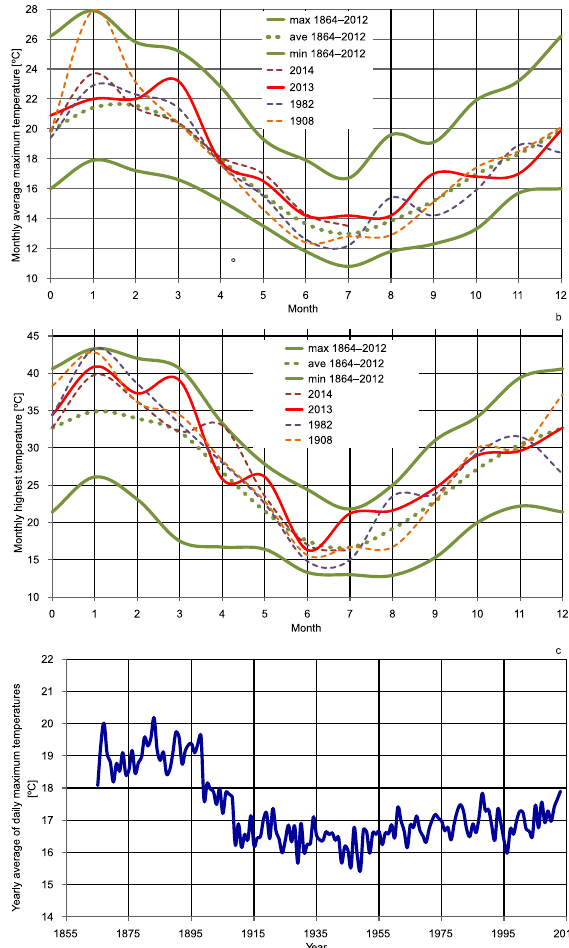
Fig. 3. Temperatures in Cape Otway Lighthouse: a) measured monthly average maximum temperatures month-by-month; b) measured monthly highest month-by- month; c) yearly average of daily maximum temperatures. Data from